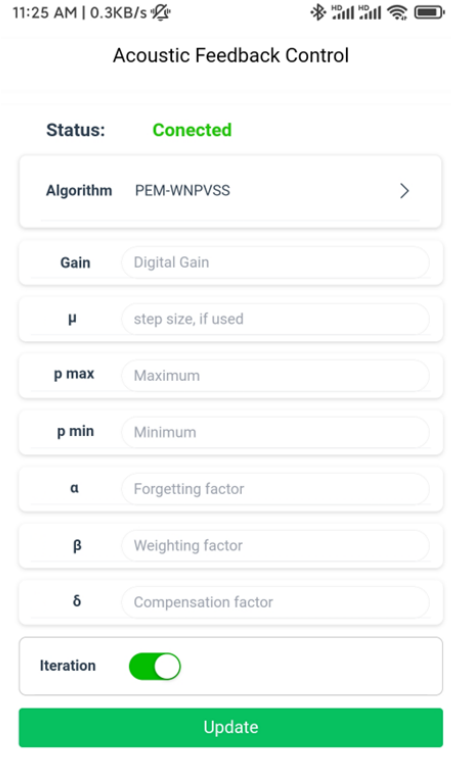
Figure 10. App interface for algorithm parameter adjustment.